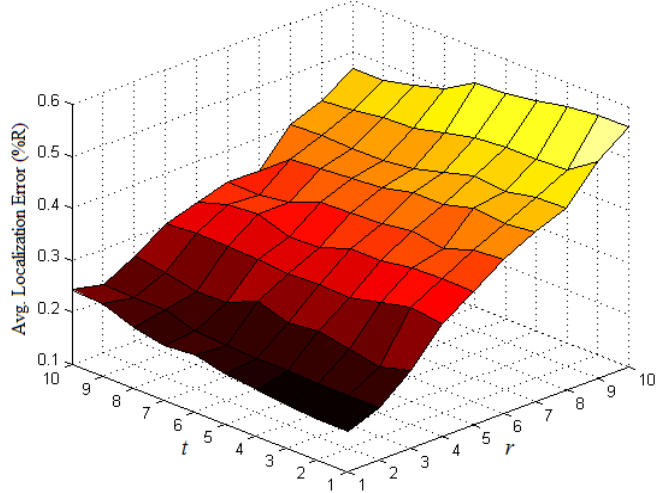
Figure 5. Average localization error as a function of r and t (isotropic network).